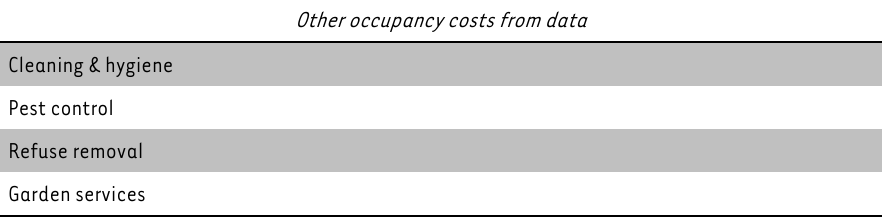
TABLE 3: Components of other occupancy